Question: Is the quantity shown trending increasing or decreasing?
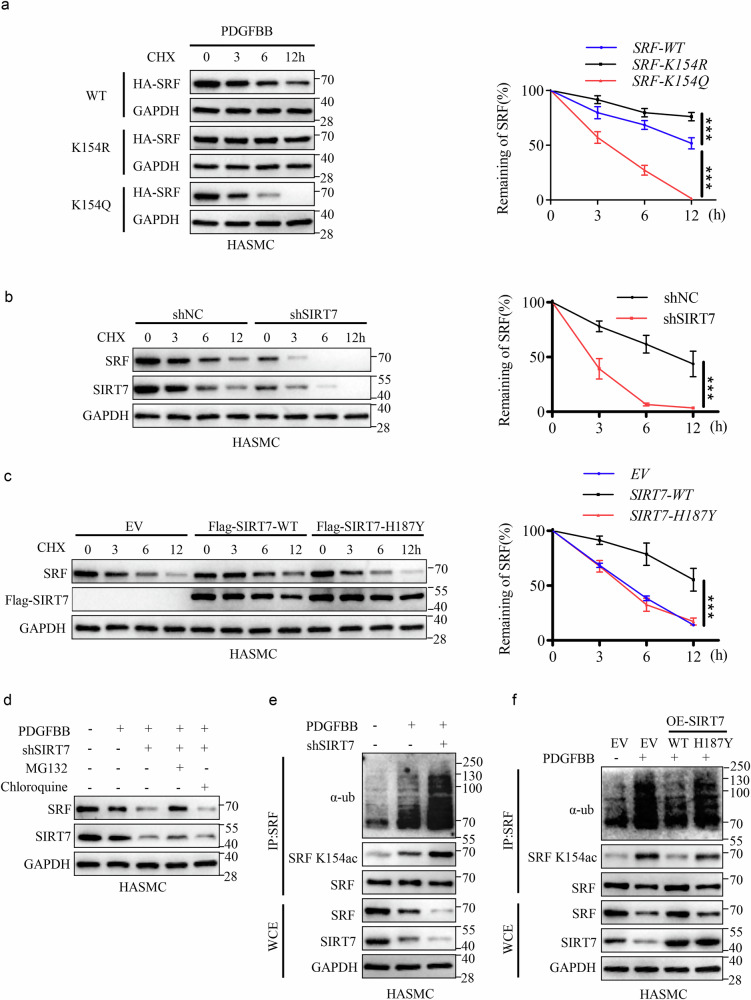
Answer: increasing